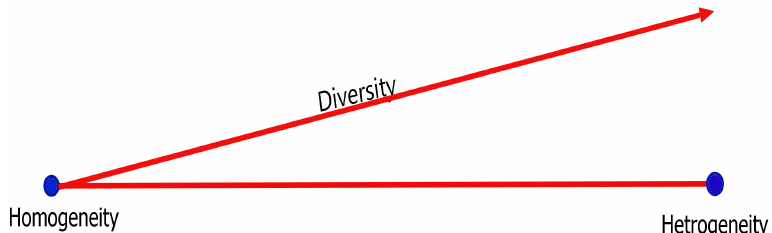
Figure 1. The Diversity